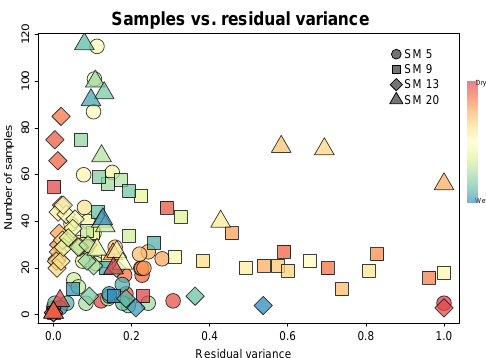
Figure 6. Scatter plot of sample size vs. normalized residual vari- ance calculated for each 0.01cm 3 cm − 3 interval. Colors indicate soil moisture conditions at each point. The plot of points show very weak linear dependence, which is further confirmed by a − 0.24 cor- relation coefficient.